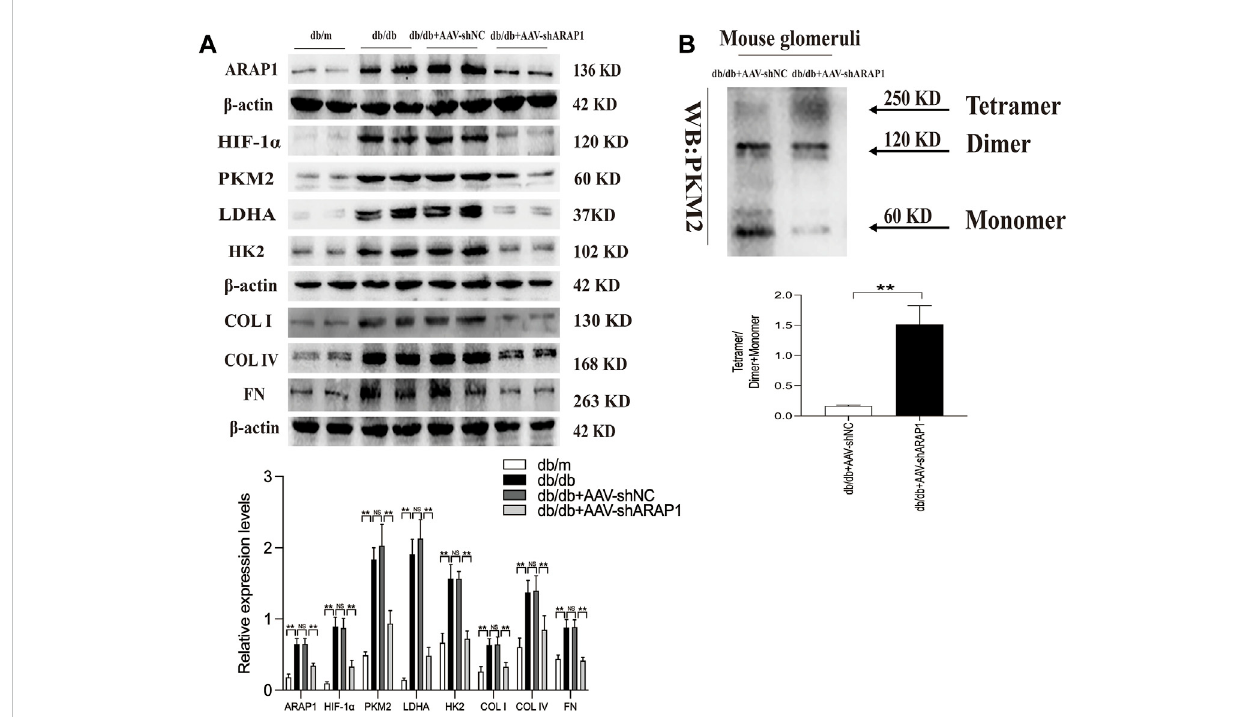
FIGURE 2 ARAP1 knockdown inhibits dimeric PKM2 expression, HIF-1 α accumulation, fi brogenesis and aberrant glycolysis, while partly restore tetrameric PKM2 formation in diabetic mouse (A) The effect of AAV2/9-shARAP1 on ARAP1, HIF-1 α , PKM2, LDHA, HK2, COL I, COL IV and FN protein expression in the isolated glomeruli lysates of mouse kidney tissues was examined by Western blot analysis. (B) Cross-linking detection of PKM2 in the isolated glomerulilysatesofmouse.Inallpanels,thedataarerepresentativeofatleastthreeindependentexperiments.Dataarepresentedasthemean±SD.